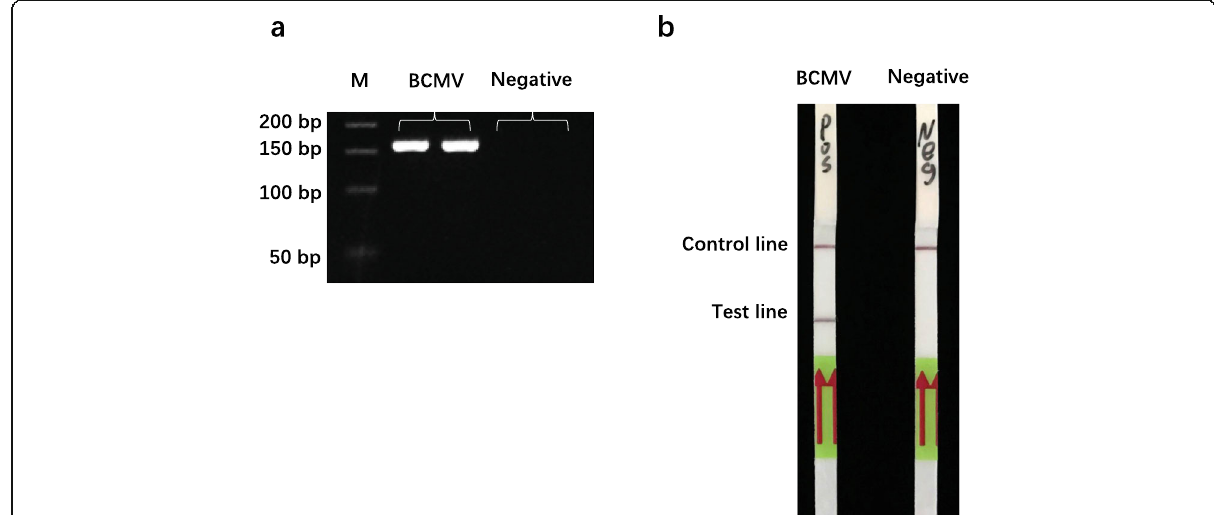
Fig. 1 Development of an RPA-LFD assay for the detection of BCMV from soybean plant tissues. a Detection of BCMV from BCMV-infected soybean plants by RT-PCR assay using BCMV-CP primers, with non-infected (healthy) plants as negative control. b Detection of BCMV from BCMV-